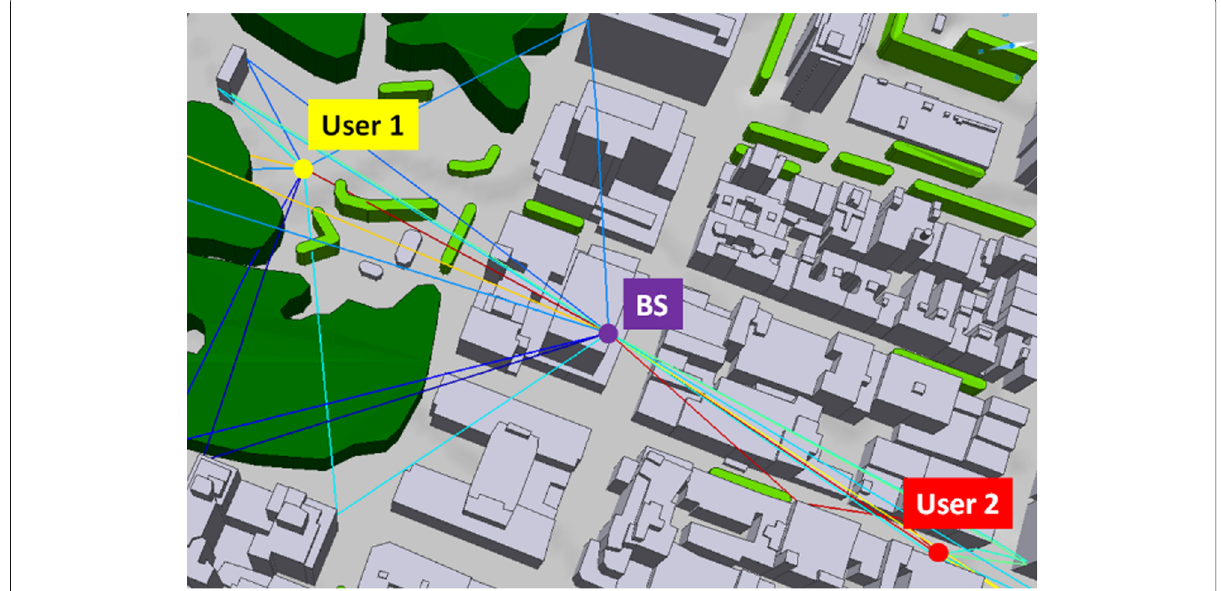
Fig. 5 Example of two users connected to the same BS having very different propagation